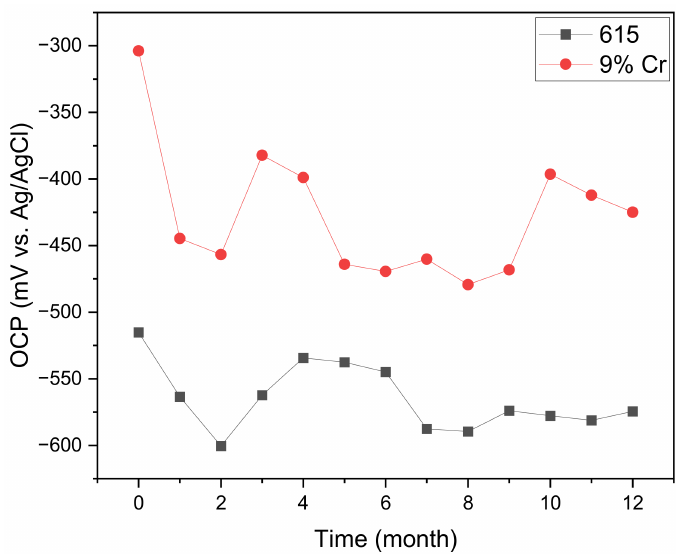
Figure 4. OCP values for ASTM 615 and ASTM 1035 as a function of time.